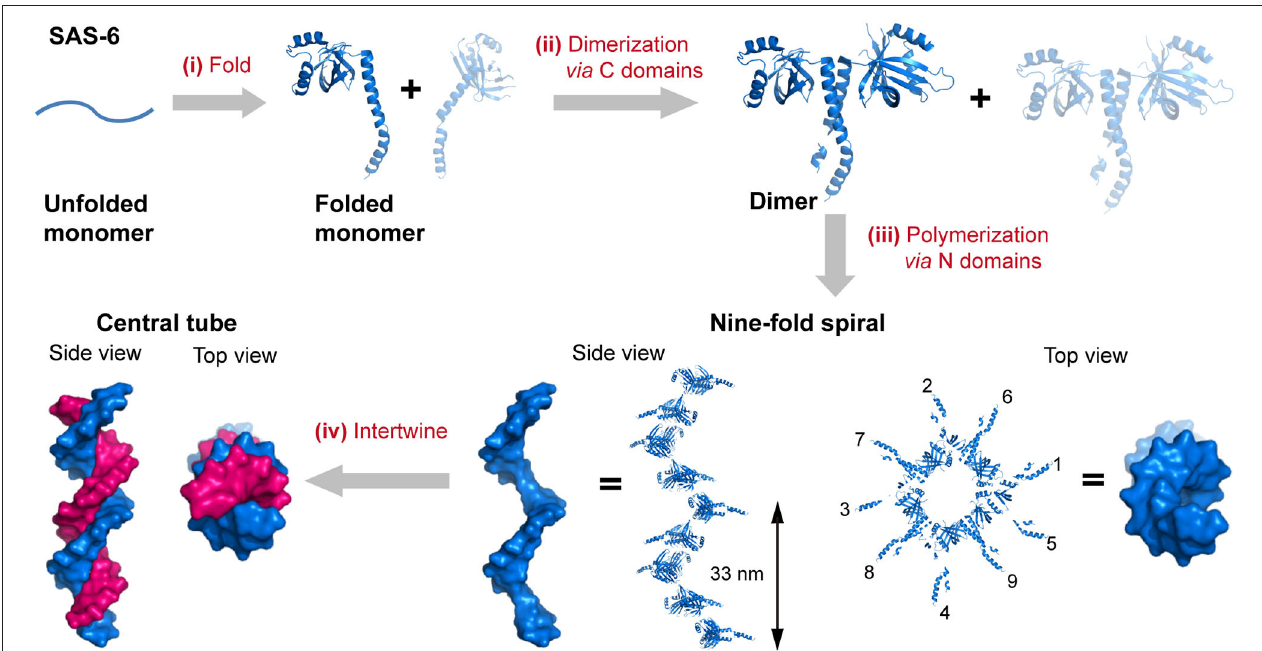
FIGURE 1 | The hierarchical organization of SAS-6. (i) A linear SAS-6 polypeptide is folded into a tertiary structure composed of a C-terminal domain and an N-terminal domain. (ii) The dimerization of SAS-6 is achieved via a coiled coil formed by the C-terminal domains. (iii) SAS-6 dimers are polymerized into a 9-fold spiral via forming N-N dimerization interfaces. (iv) Two spirals intertwine around each other. SAS-6 structures are generated by using crystallography data (PDB ID